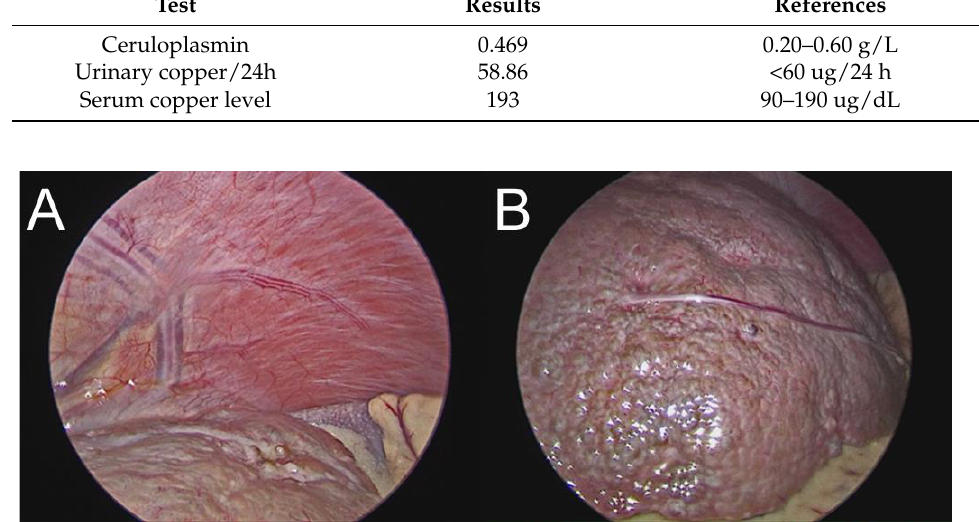
Figure 2. Laparoscopic examination of the liver. ( A ) This image reveals the dilated and distorted blood vessels suggestive for collateral vascularization, while ( B ) depicts the nodular and irregular surface of the liver, with a pale color specific for cirrhosis.